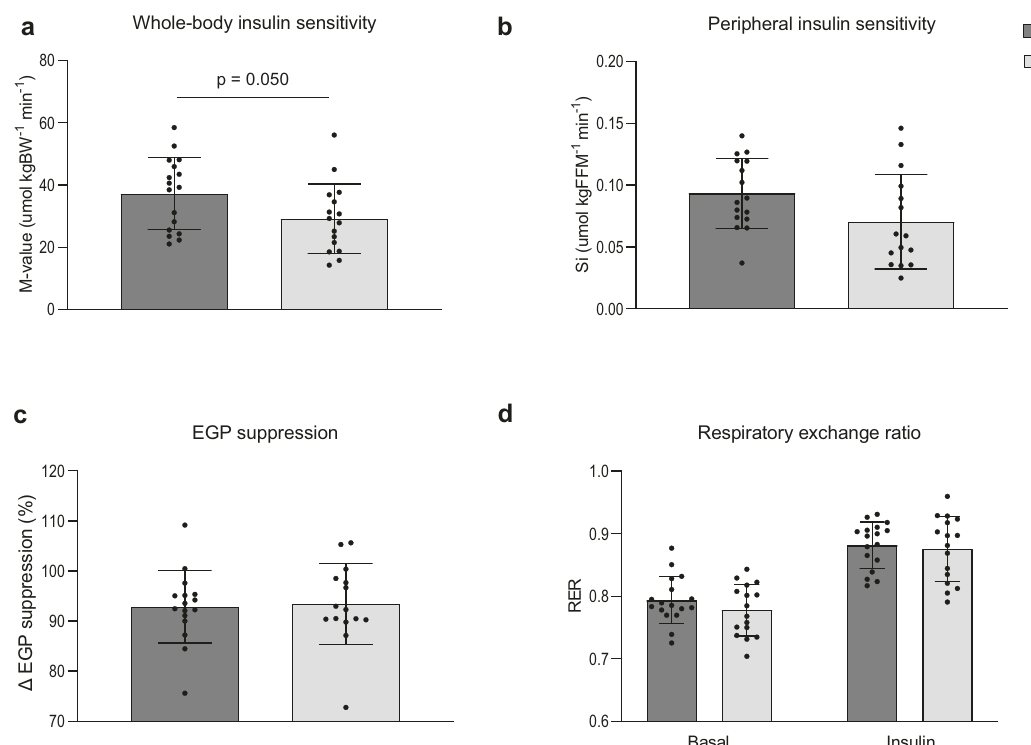
Fig. 2 Effect of aging on insulin sensitivity and substrate selection. a Whole-body insulin sensitivity based on the M -value measured during a hyperinsulinemic-euglycemic clamp. b Insulin-stimulated glucose uptake, corrected for plasma insulin and glucose levels (S i ) and expressed per kg FFM. c EGP suppression, calculated as the percentage insulin-suppressed EGP from the basal EGP d Respiratory exchange ratio measured before, in resting conditions (Basal), and during insulin stimulation (Insulin). Dark gray bars represent the young individuals (Y, n = 17), light gray bars represent older individuals (O, n = 15). One participant from O was excluded for analysis due to a violation of the protocol instructions. For one O participant, tracer data could not be analyzed. Values are presented as mean ± SD (with individual data points), p = 0.05 denotes a signi fi cant difference between the two groups (two-sided, independent samples t -test). M -value mean glucose infusion rate, BW body weight, S i insulin-stimulated glucose disposal, FFM fat-free mass, EGP endogenous glucose